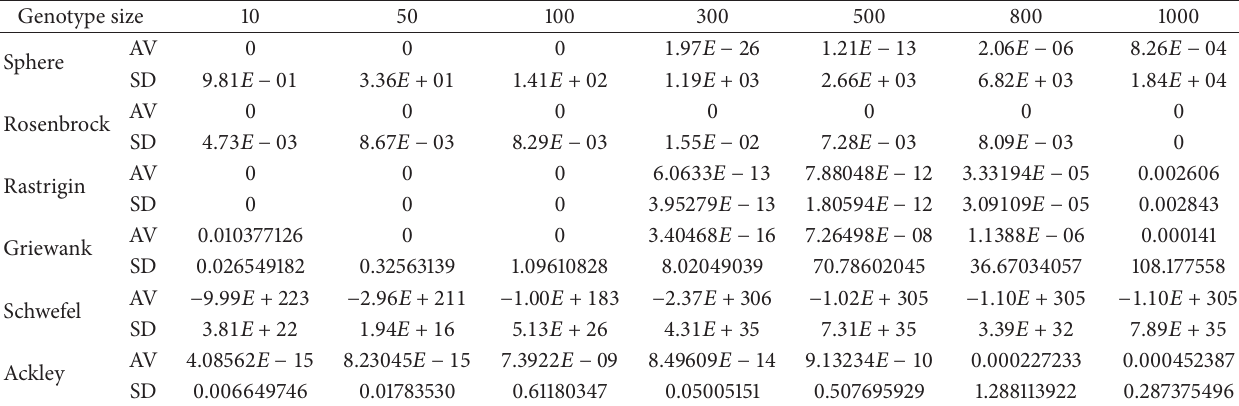
Table 2: Test results of the MBO algorithm for the genotype sizes of 10, 50, 100, 300, 500, 800, and 1000; number of runs = 30; SD: standard deviation, AV: global minimum average; generation = 10000.